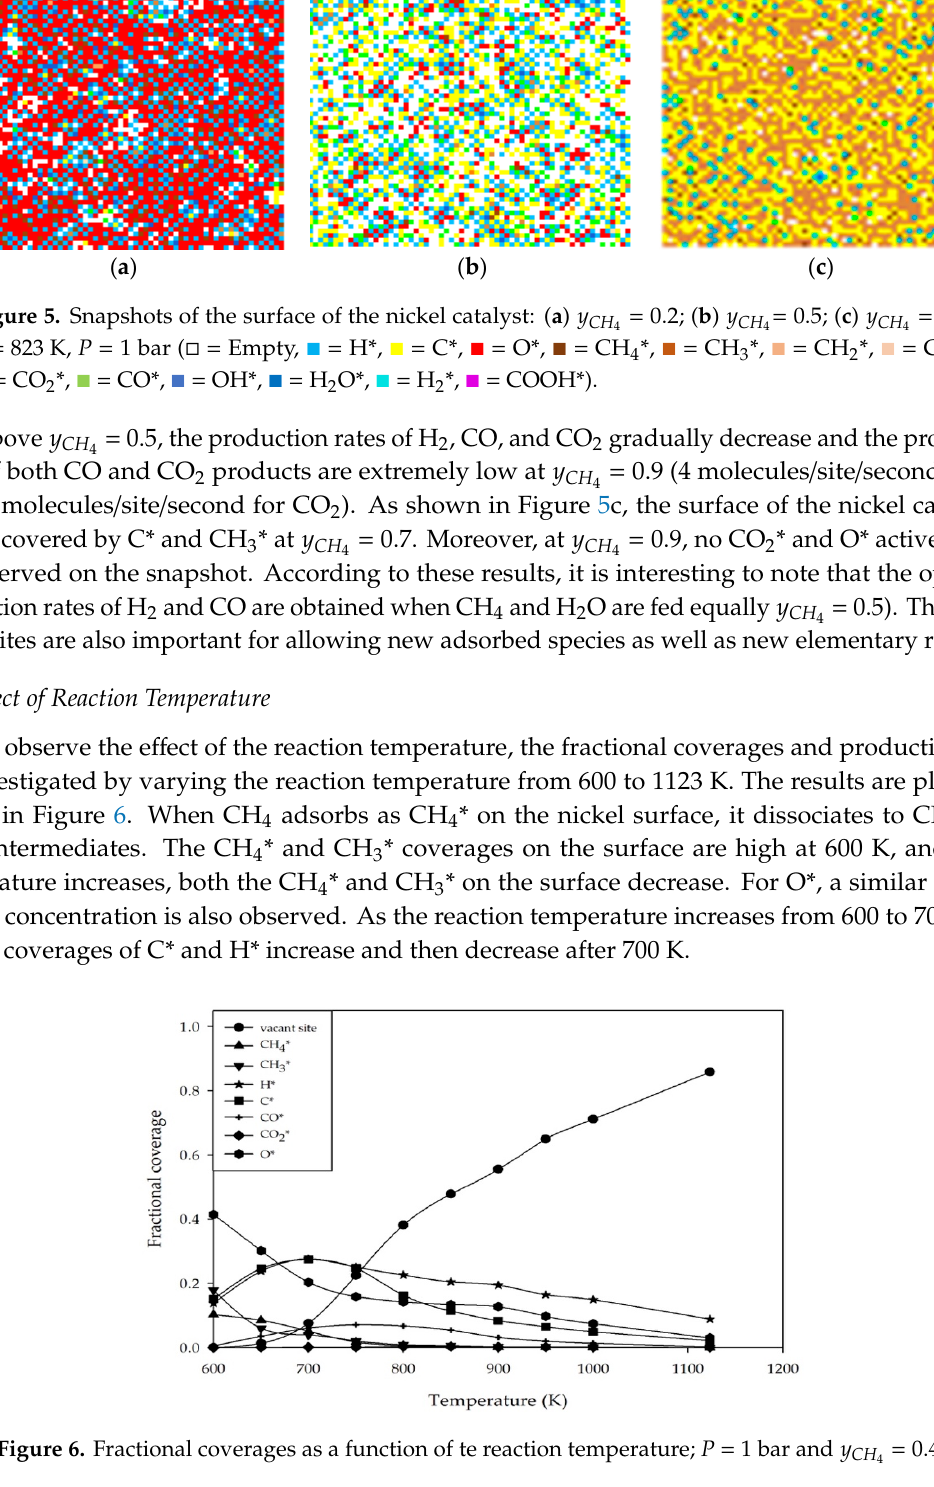
Figure 6. Fractional coverages as a function of te reaction temperature; P = 1 bar and 𝑦 (cid:3004)(cid:3009)